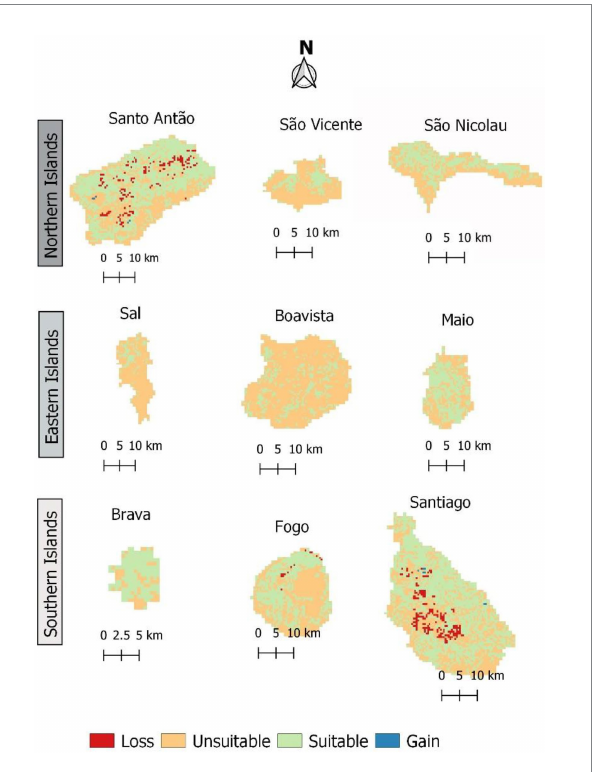
FIGURE 7 Current suitable area for Faidherbia albida in Cabo Verde. Habitat suitability values are provided in the 0–1,000 format, to facilitate reading.